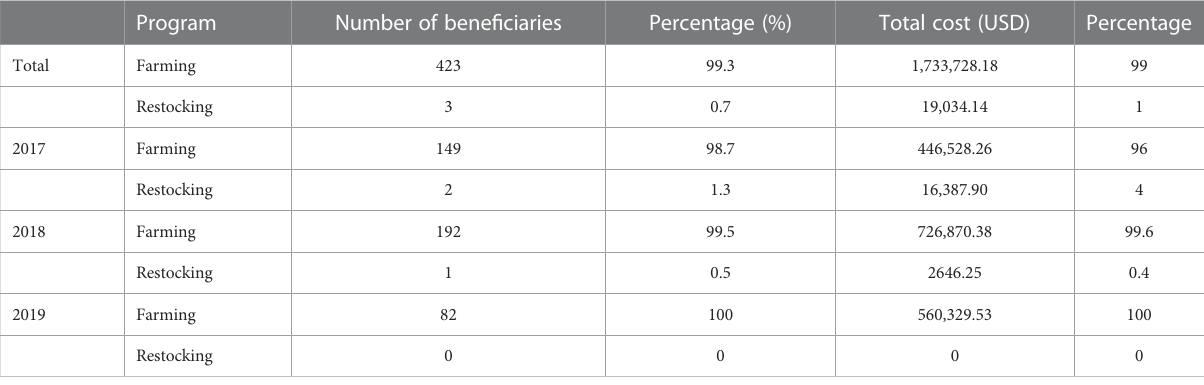
TABLE 3 Total number of approved projects by program duration in years and cost (USD) related to seaweed cultivation and restocking in Chile (SUBPESCA, 2017; SUBPESCA, 2018a; SUBPESCA, 2018b; SUBPESCA, 2018c; SUBPESCA,